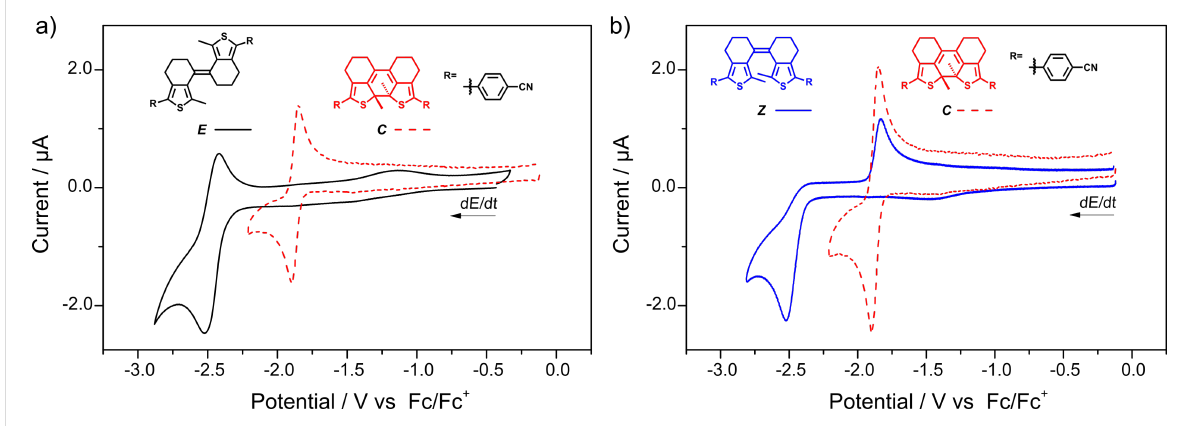
Figure 4: Cyclic voltammograms of sDTE 66 -PhCN . The reduction of a) E- sDTE 66 -PhCN (black line) is reversible, whereas the reduction of b) Z- sDTE 66 -PhCN (blue line) yields the closed isomer, indicated by the characteristic oxidation wave of C- sDTE 66 -PhCN (red dashed line), gener- ated photochemically. Experiments in a) DMF with 0.1 M Bu 4 NPF 6 , c = 5 ∙ 10 − 4 M, dE / dt = 1 V s − 1 and b) MeCN with 0.1 M Bu 4 NPF 6 , c = 5 ∙ 10 − 4 M, dE / dt = 1 V s − 1